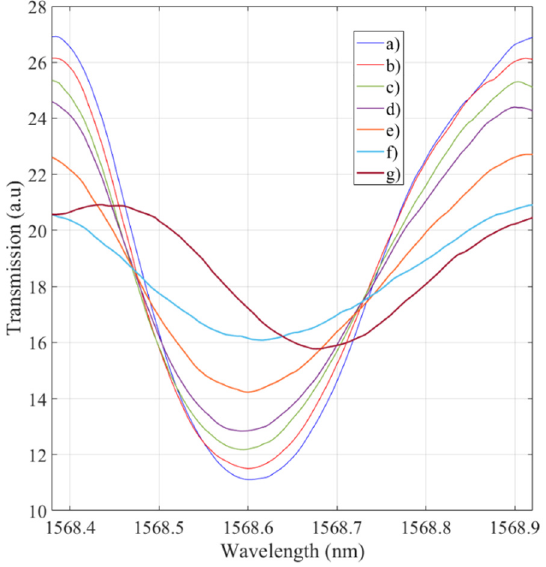
Figure 21. Zooming of the TFBG spectra on certain cladding resonance upper and lower peaks.